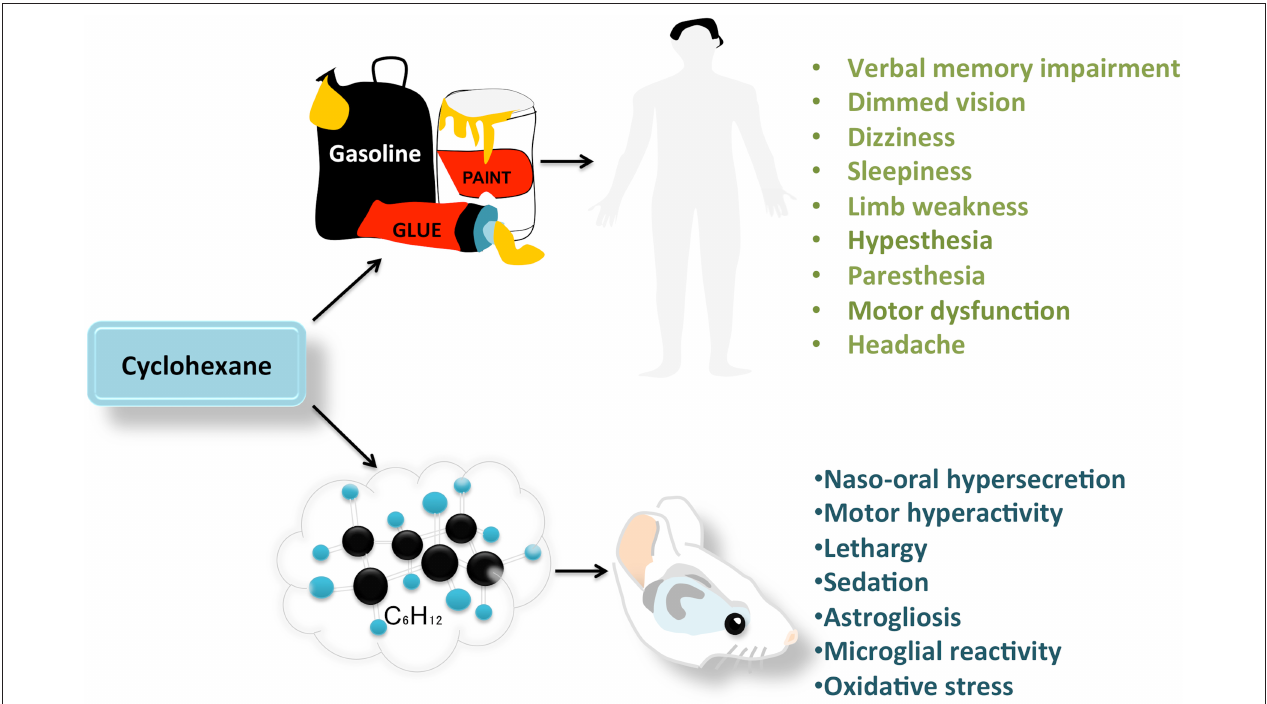
FIGURE 1 | Behavioral and histological changes observed after cyclohexane inhalation in humans and